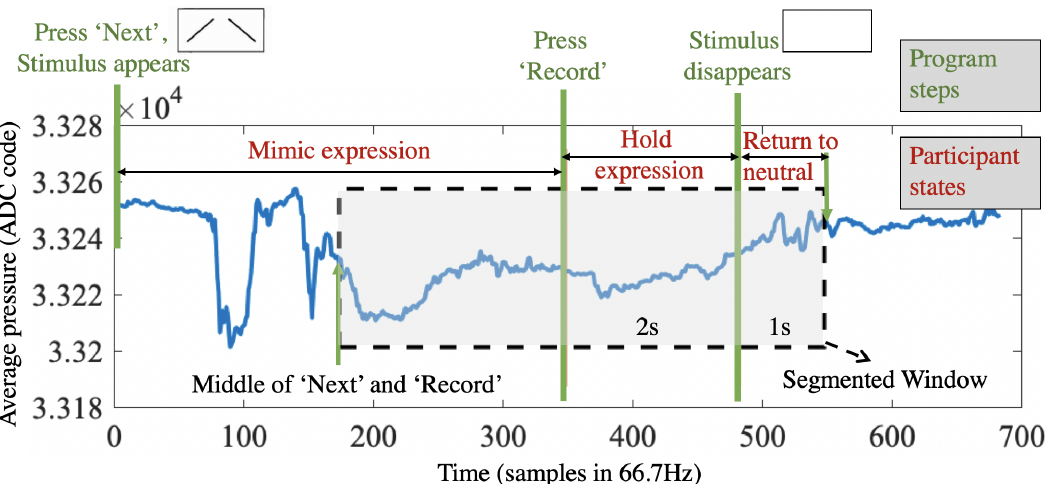
Figure 3. Window segmentation of Experiment 1, so that it can best cover the transition between the neutral expression and the mimicking